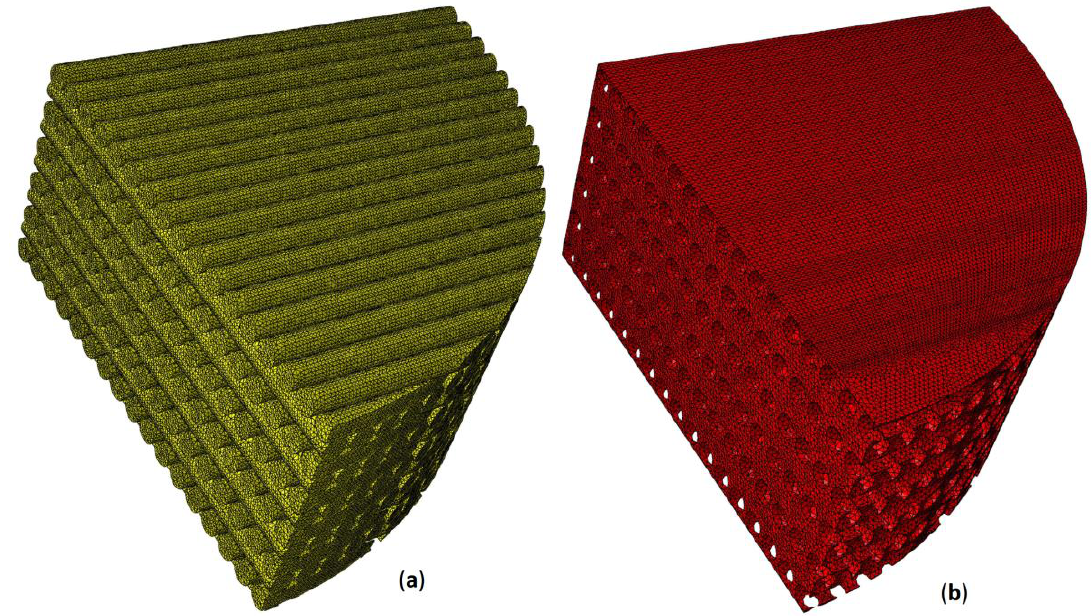
Figure 3. Finite element mesh utilized to model the scaffold ( a ) and the granulation tissue ( b ) including poroelastic four-node tetrahedral elements (C3D4P).